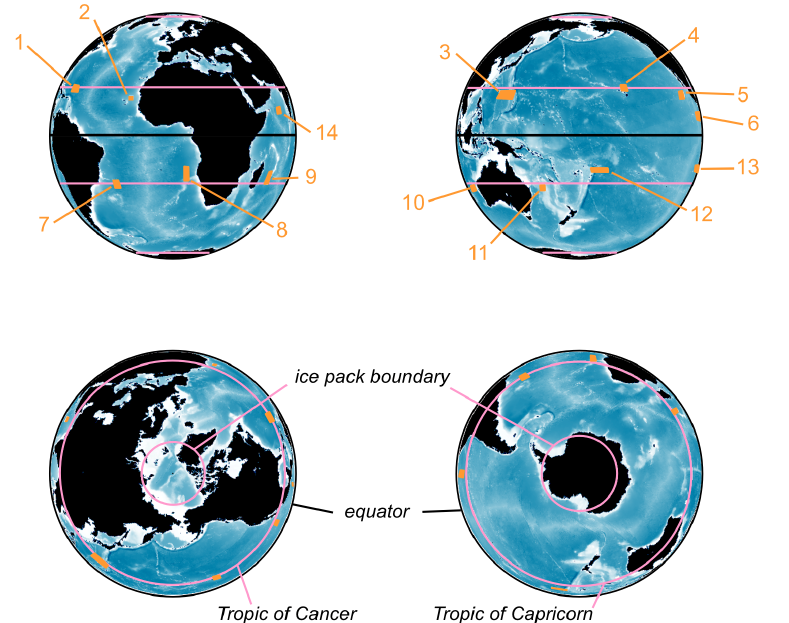
Figure 2. Configuration of the simulated Earth system and positioning of the Distinct Population Segments, numbered from 1 to 14: 1—West Indies, 2—Cabo Verde, 3—Western North Pacific, 4—Hawaii,